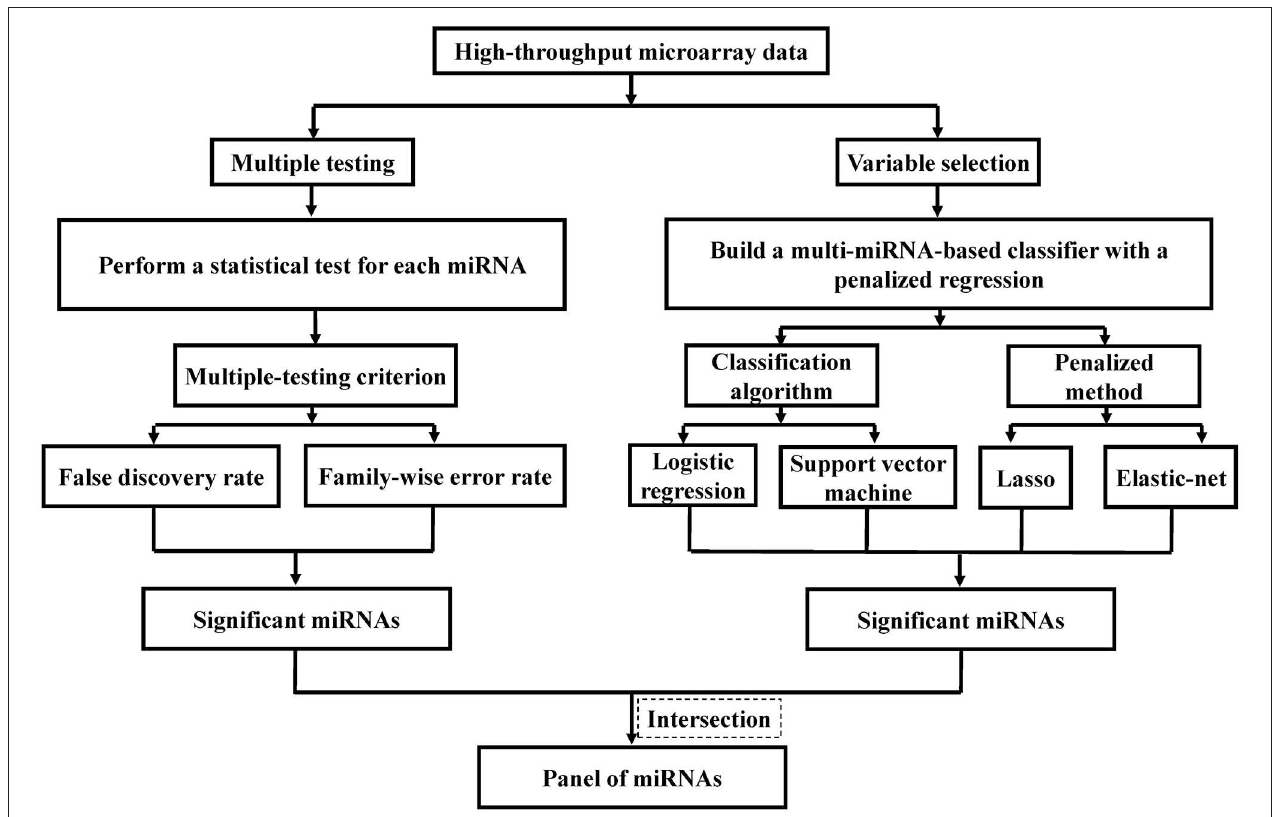
FIGURE 1 | Flowchart of identifying predictive miRNAs by performing representative feature selection algorithms.